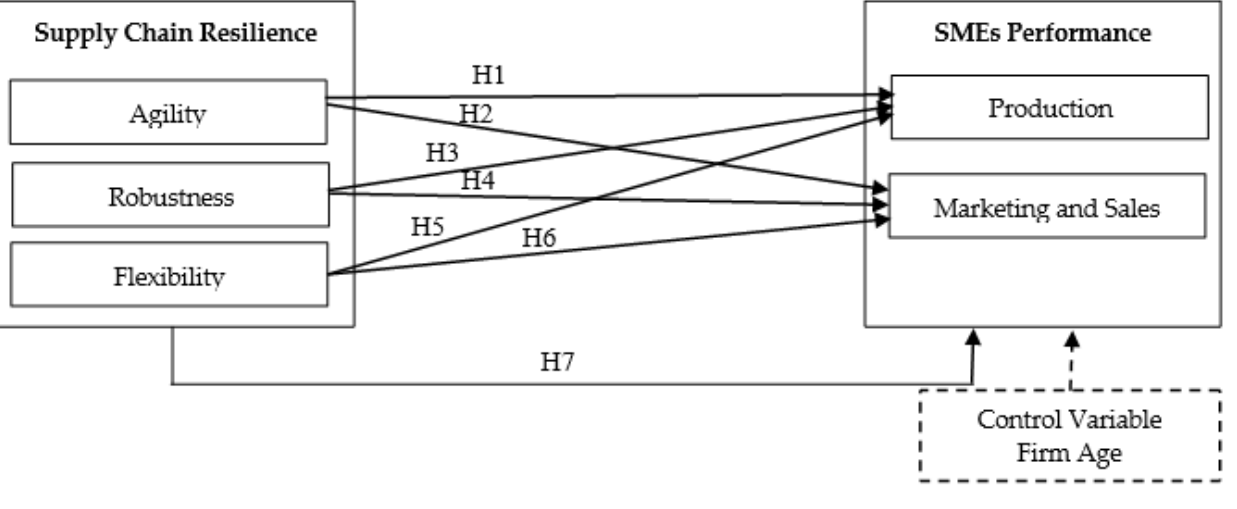
Figure 1. Conceptual model.